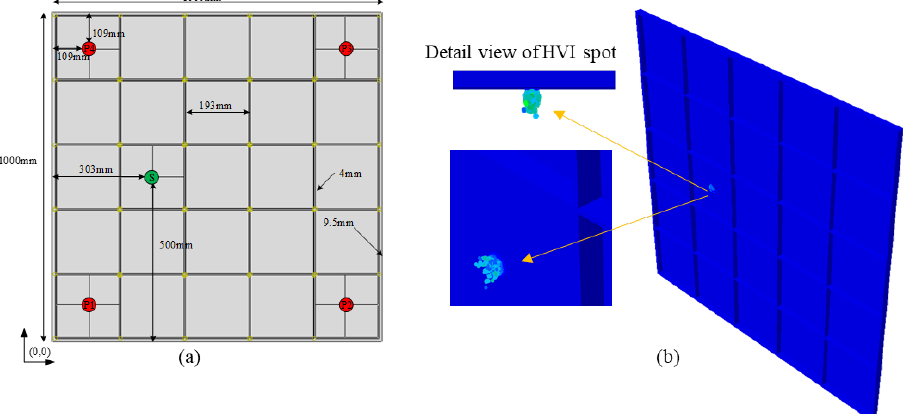
Figure 4. ( a ) Schematic diagram of the transducers configuration in simulation and experiment and ( b ) a screenshot of simulation, t = 4.5 × 10 − 5